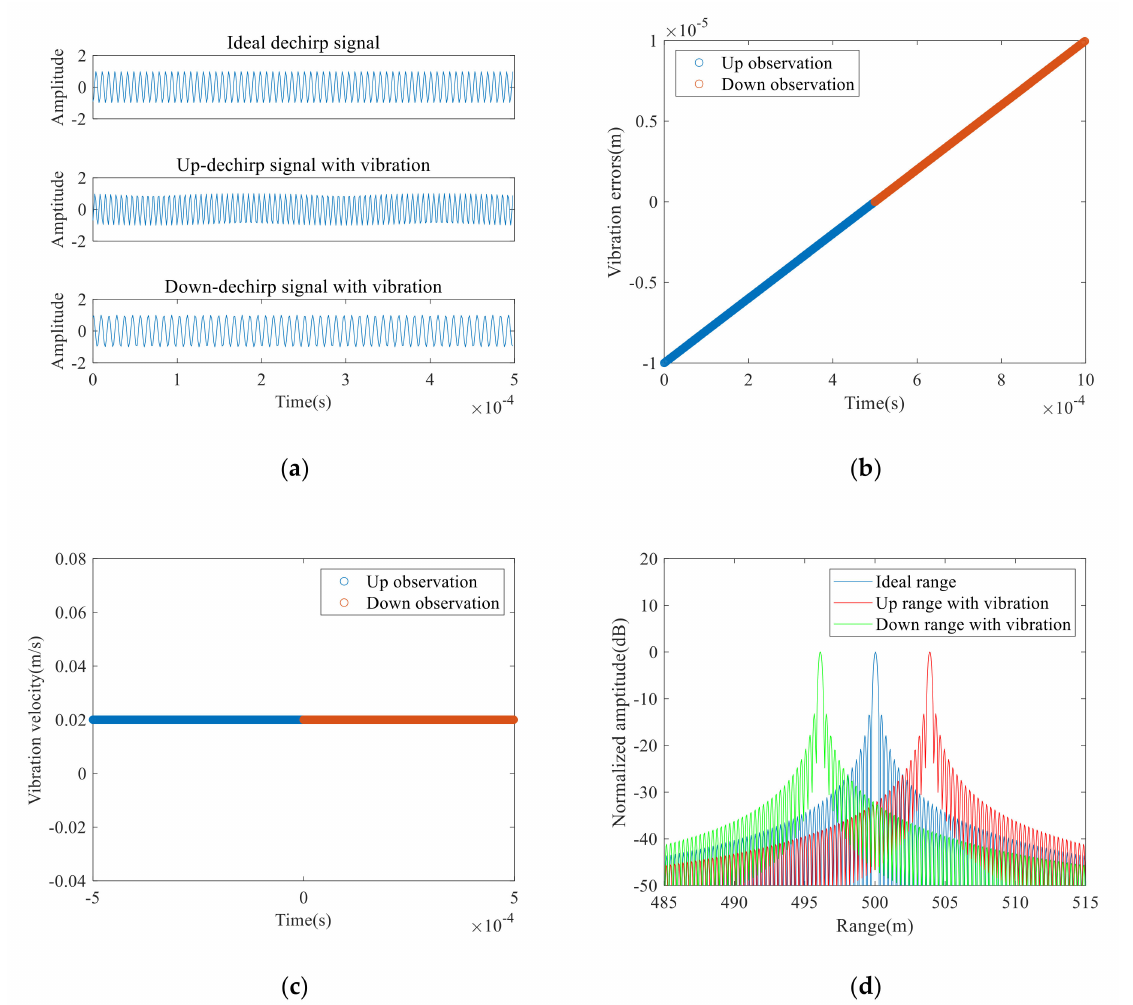
Figure 3. ( a ) Dechirp signals, ( b ) Vibration errors of up and down observations, ( c ) Vibration velocities of up and down observations and ( d ) One-dimensional range distributions under the condition of constant vibrations.